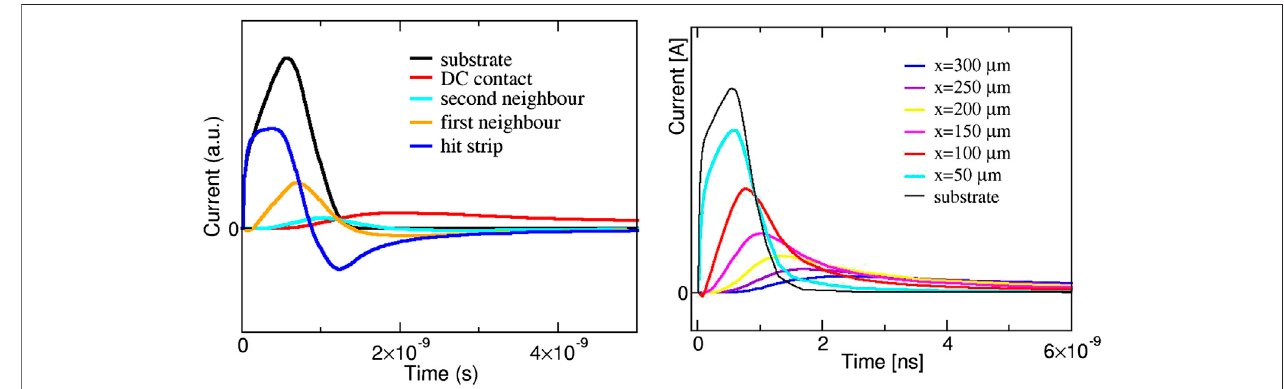
FIGURE 12 | Left, current pulses at different electrodes as an example of simulated AC-LGAD. Right, for the same example, current pulses at the DC contact for different interaction points X of the mip.